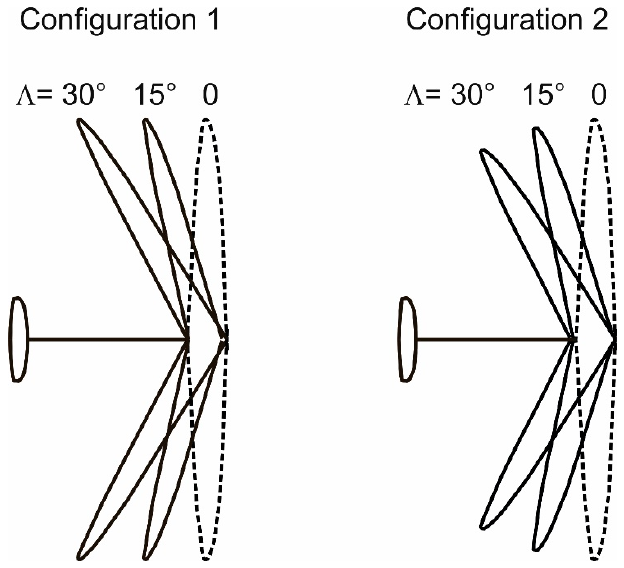
Figure 14. Swept wing configurations 1 and